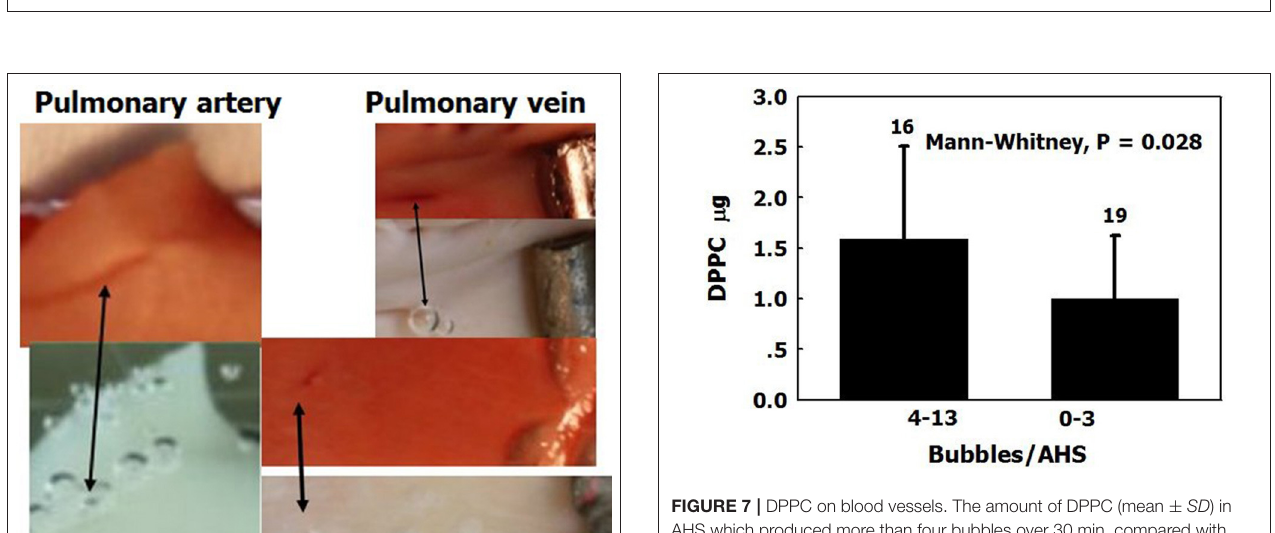
FIGURE 5 | Bubble-producing spots. An example of defined spots, as revealed by bubble development from a pulmonary vein and aorta. Some spots produced just one bubble at a time, whereas others produced several bubbles at once.